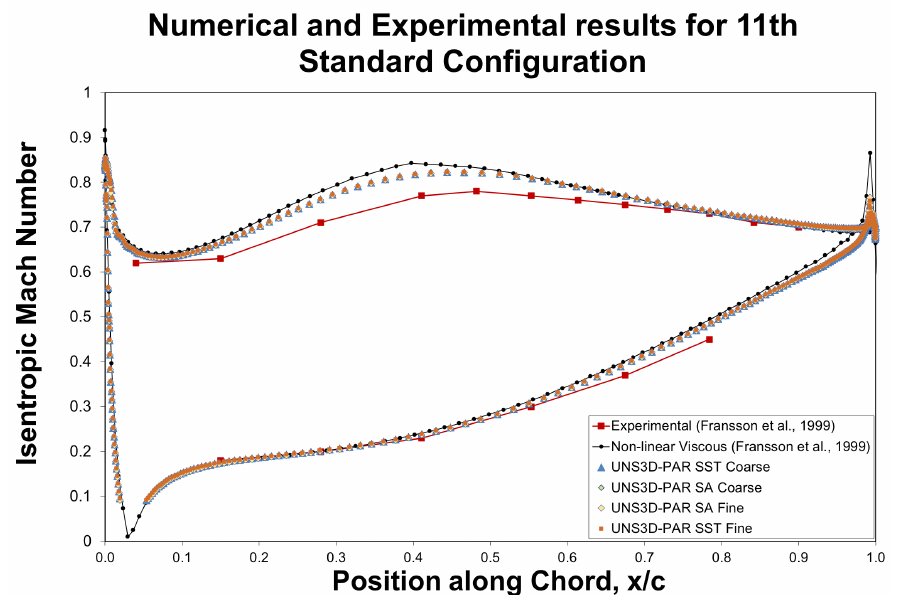
Figure 23. Measured and predicted Mach number on the eleventh standard